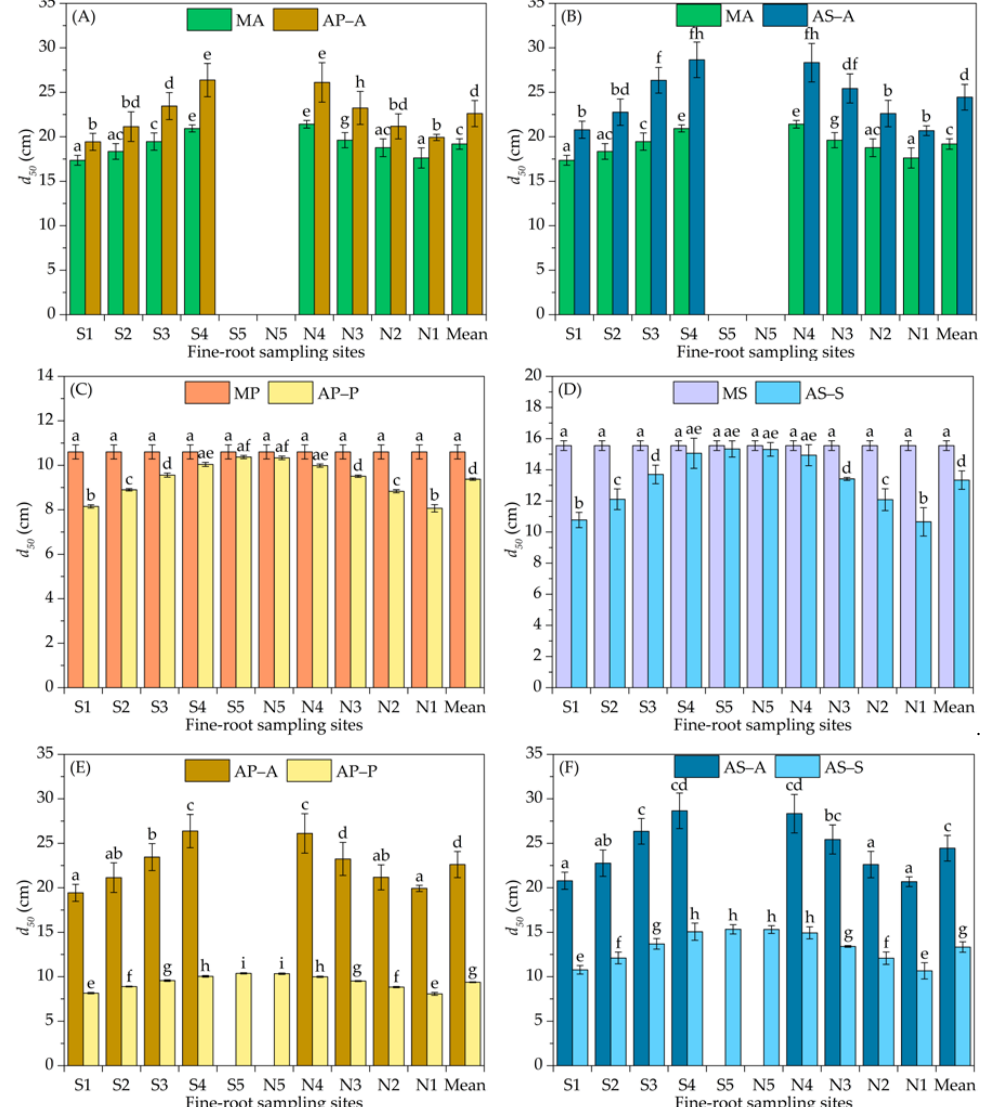
Figure 5. Values of the depth of 50% of the cumulative fine-root biomass density ( d 50 ) for ( A ) monocropped apple trees (MA) and intercropped apple trees in apple–peanut intercropping systems (AP–A); ( B ) monocropped apple trees (MA) and intercropped apple trees in apple–soybean intercropping systems (AS–A); ( C ) monocropped peanut plants (MP) and intercropped peanut plants in apple–peanut intercropping systems (AP–P); ( D ) monocropped soybean plants (MS) and intercropped soybean plants in apple–soybean intercropping systems (AS–S); ( E ) intercropped apple trees (AP–A) and intercropped peanut plants in apple–peanut intercropping systems (AP–P); and ( F ) intercropped apple trees (AS–A) and intercropped soybean plants (AS–S) in apple–soybean intercropping systems. The error bars indicate the standard deviations. The means with different letters within a row or column are significantly different ( p <0.05).